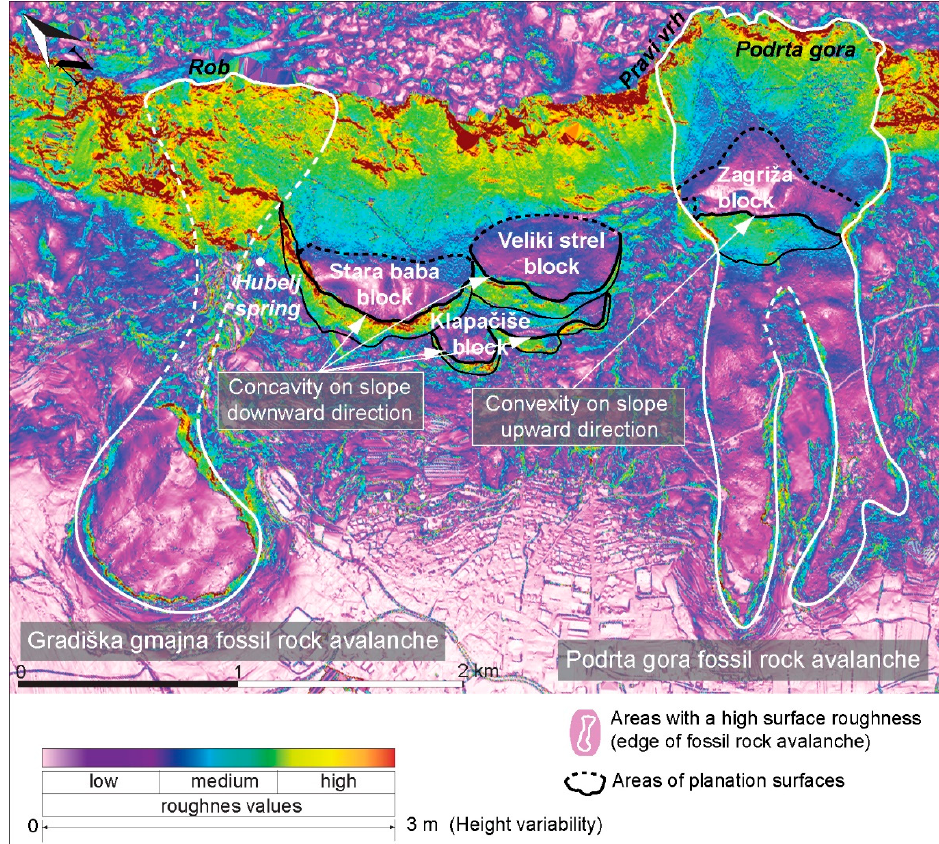
Figure 3. Map of HV with marked individual sedimentary bodies of Gradiška Gmajna and Podrta gora rock avalanches and larger leveling area of Stara baba, Veliki strel, Klapa č iše, and Zagriža gravity carbonate blocks.